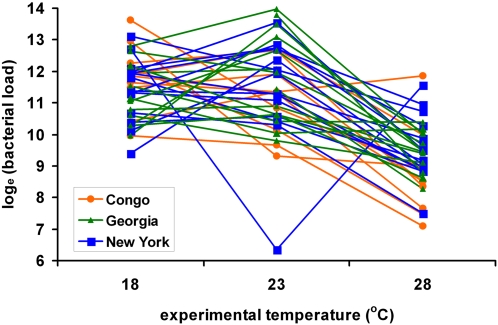
Genotype-by-environment interactions in bacterial load sustained after infection at three experimental temperatures.Least squares mean bacterial loads (Model B, see Materials and Methods) are plotted for D. melanogaster genotypes isolated from Congo, Africa (orange circles), Georgia, USA (green triangles), and New York, USA (blue squares). The genotype-by-temperature interaction is highly significant, p = 0.0015. Removal of the outlier point at 23°C does not meaningfully change the results.